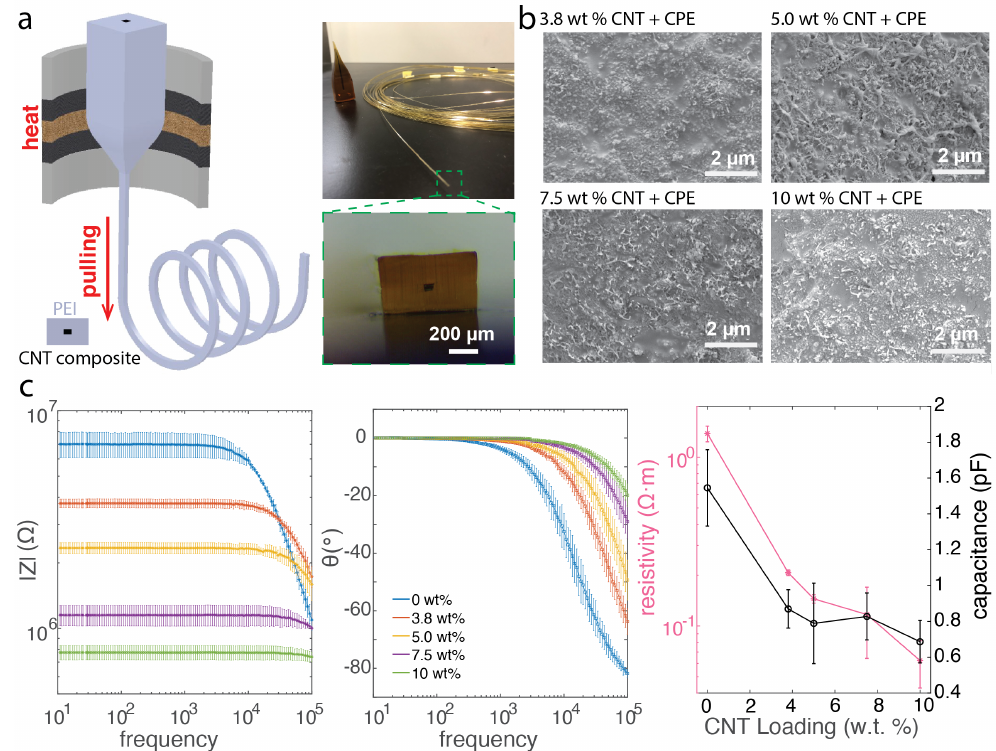
Figure 2. The CNT nanocomposite fibers fabricated via the thermal drawing process and their electrical characterizations. ( a ) A schematic of the thermal drawing process and photo of a fiber with its cross − section. ( b ) The scanning electron microscope images of the CNT composites with different loadings. ( c ) The electrical impedance analysis of the thermally drawn CNT composite fibers. The electrical impedance measurements were performed across different samples (N =